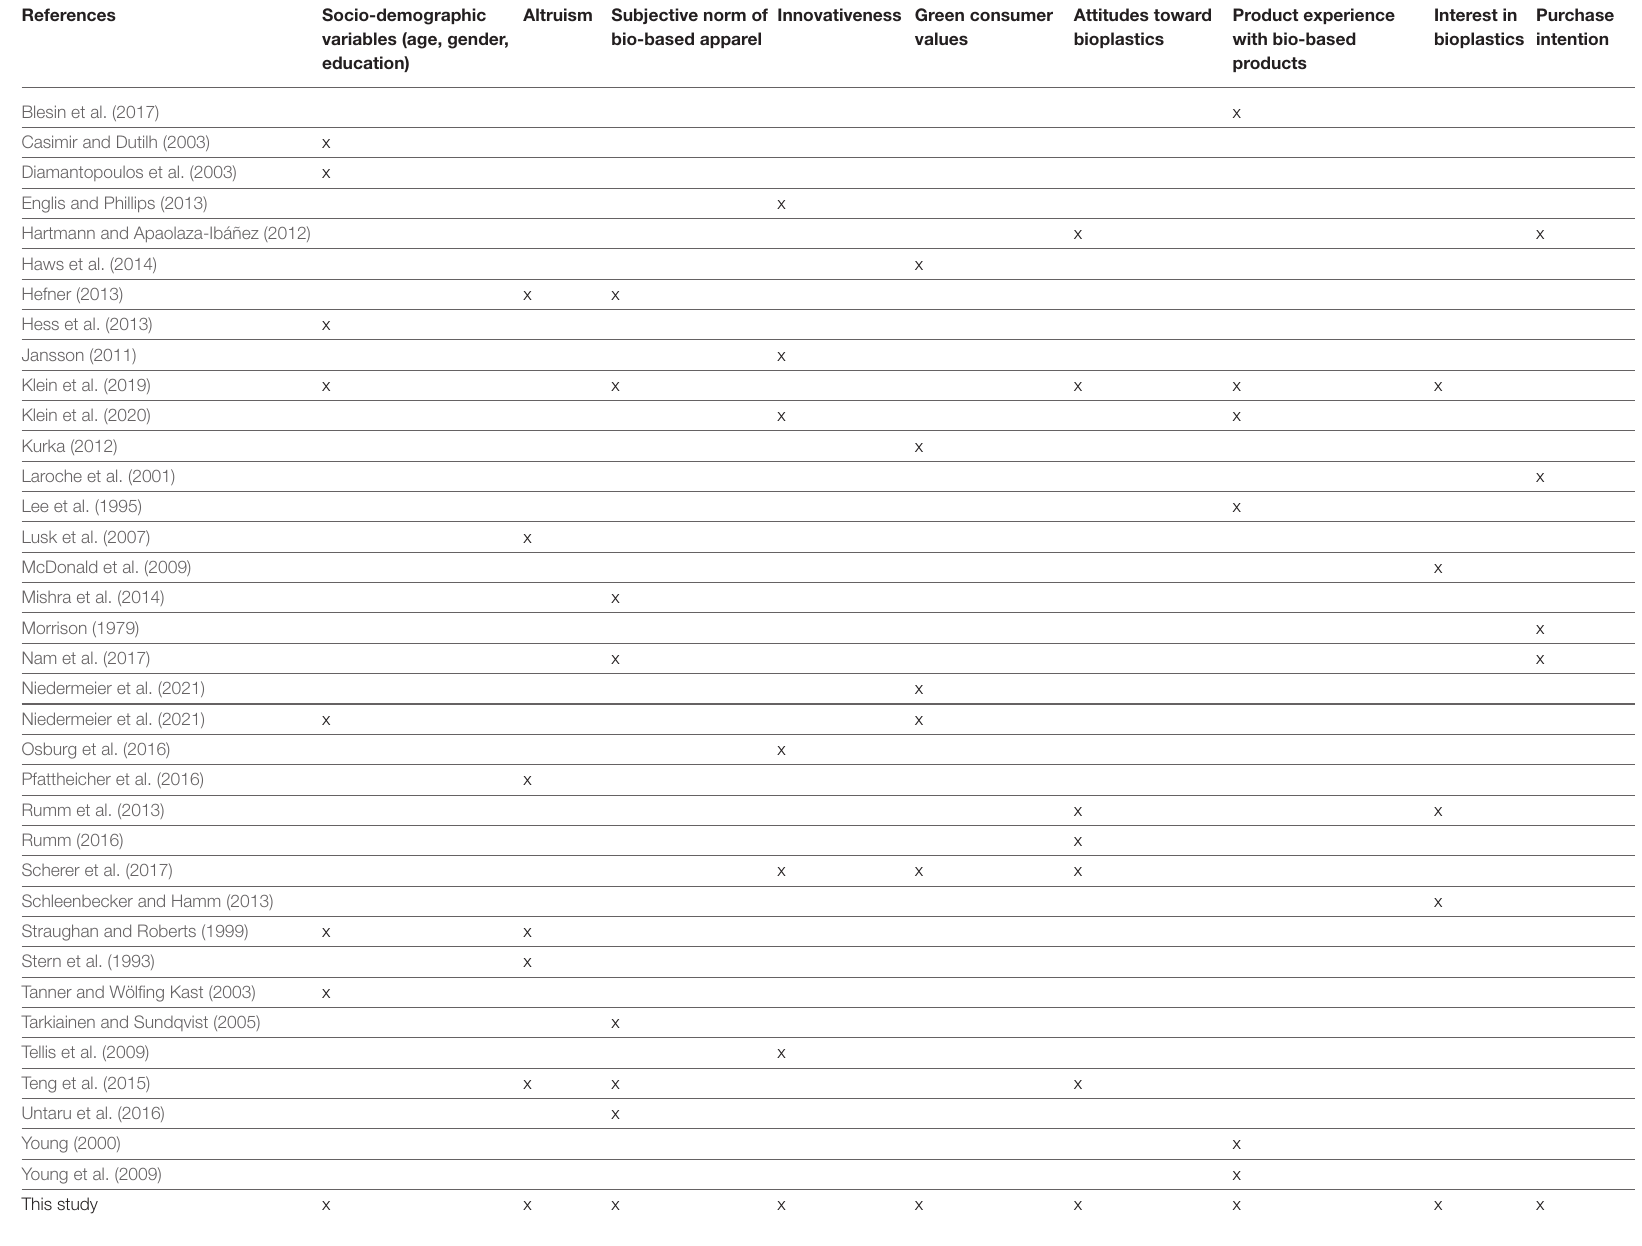
TABLE 1 | Overview of analysis of influencing factors on consumers’ price preferences for purchasing green